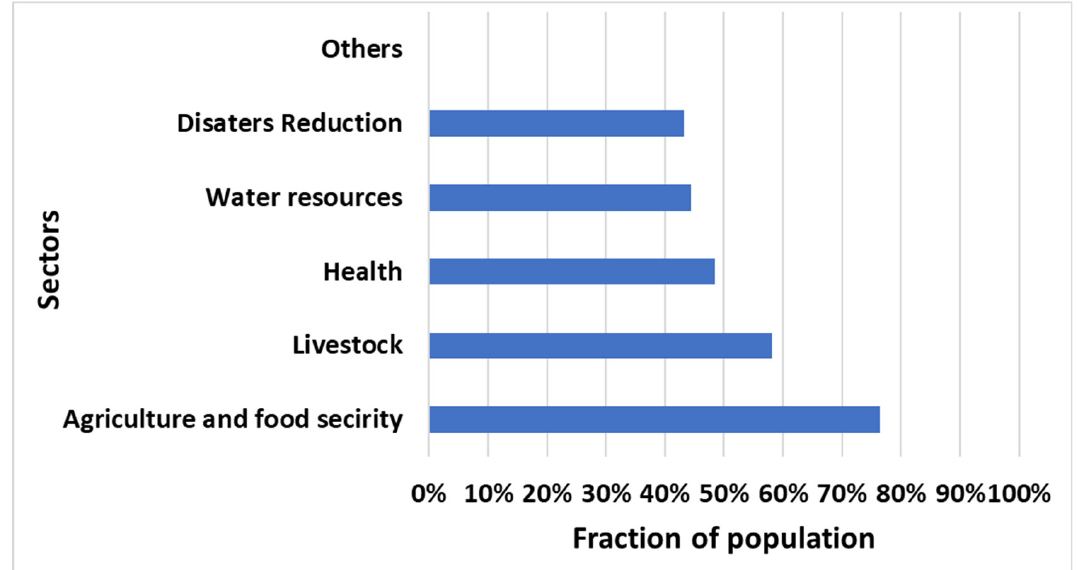
Figure 4. Use of agrohydroclimatic information by local producers according to sectors in the communes surveyed in Western Niger.